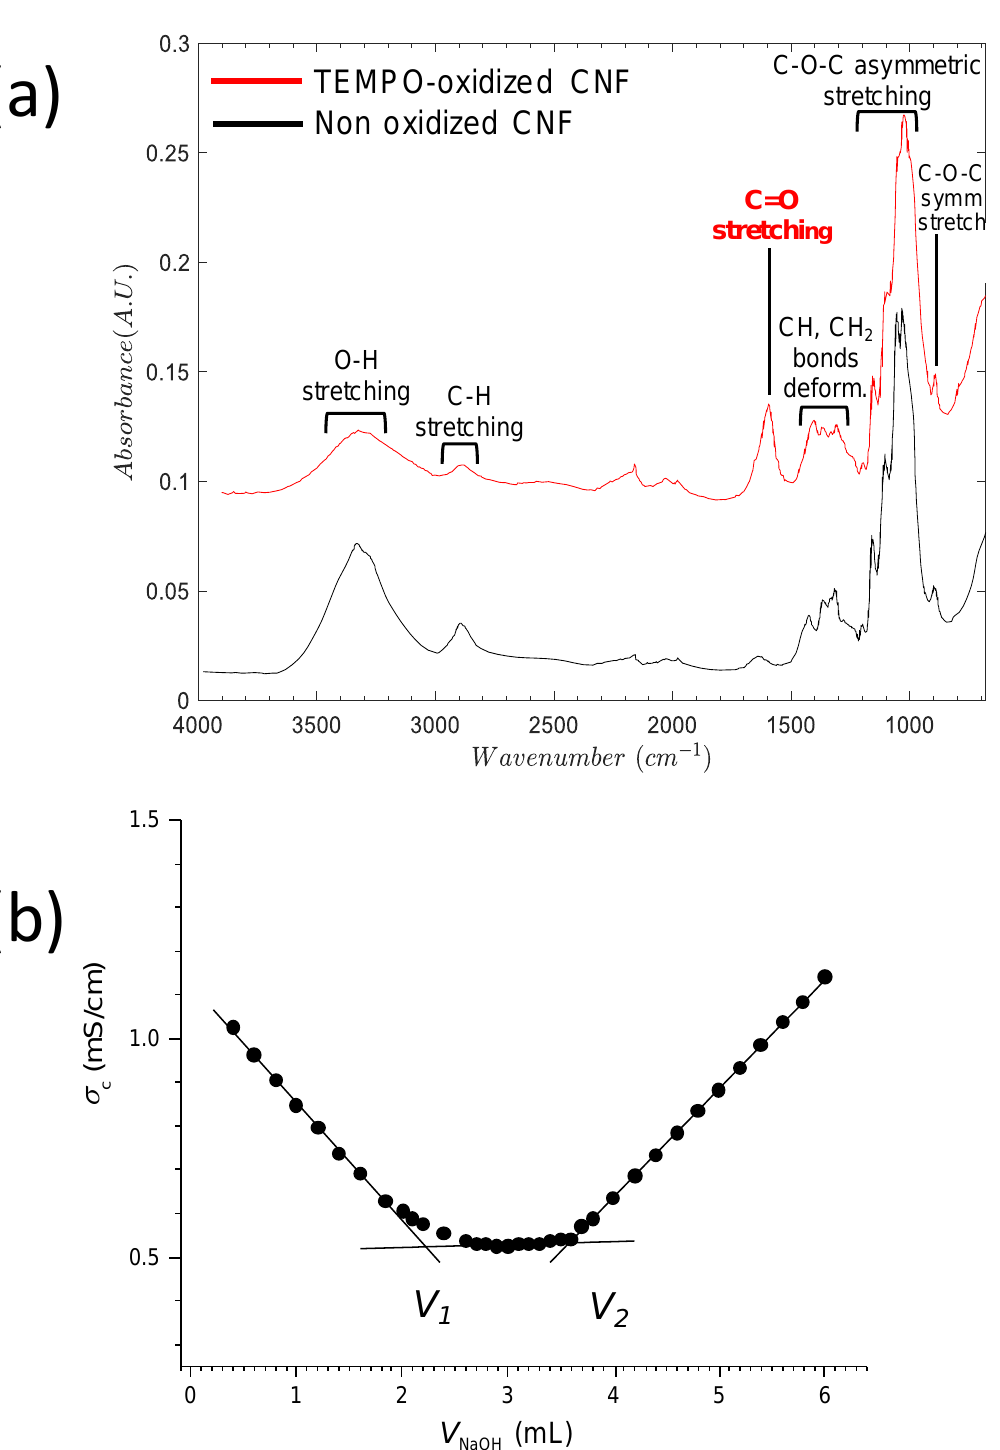
Figure 2. ( a ) ATR-FTIR spectra of the starting non-oxidized and the TEMPO-oxidized cellulose nanofibers. ( b ) Determination of the degree of oxidation (DO) by electric conductivity titration method. The corrected conductivity σ c was related to the measured conductivity σ m according to σ c = σ m ( V i + V NaOH ) / V where V i (= 83 mL) was the initial volume of the acidic CNF suspension ( m = 0.102 g, pH = 2.5) and V NaOH is the added NaOH volume ( C NaOH = 1 M). The value of DO was deduced from parameter ∆ V = V 2 − V 1 (V 2 = 3.59 mL, V 1 = 2.28 mL) according to Equation